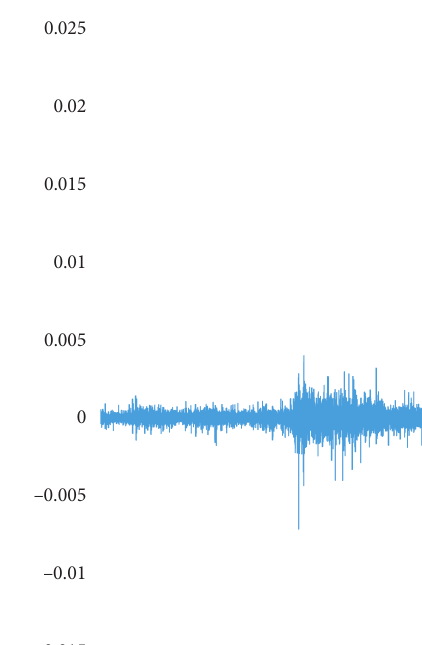
Figure 4: Return yield curve at minute level of CSI 300 index